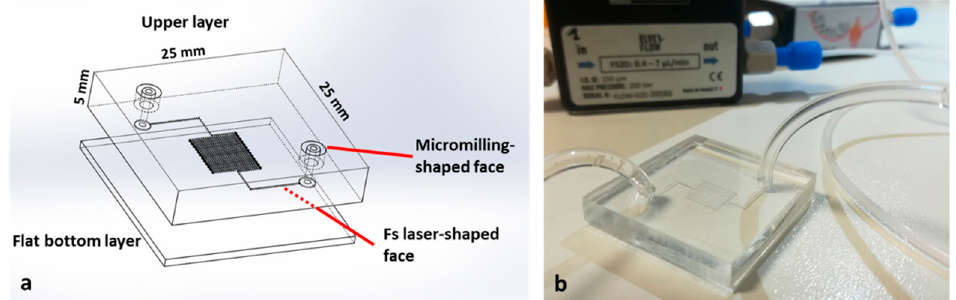
Figure 4. Features of the cell capture device ( a ). PMMA microfabrication allowed for complete transparency of the device. Inlets and outlets were designed to perfectly fit with capillary tubes ( b ).